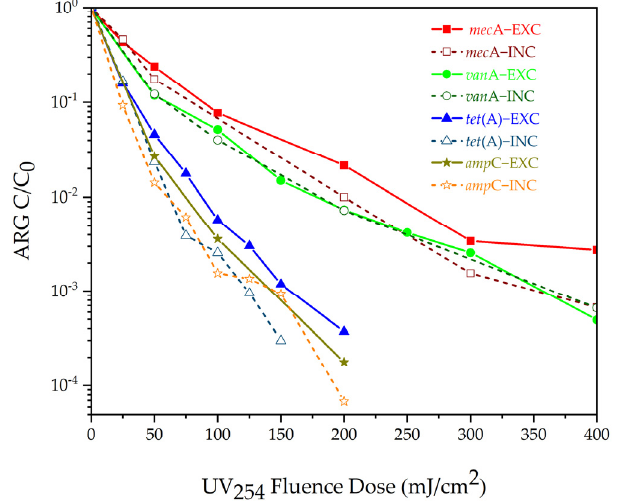
Figure 3. UV ( λ = 254 nm) disinfection curves for antibiotic resistance genes (ARGs). INC = Intracellular. EXC = extracellular [123].